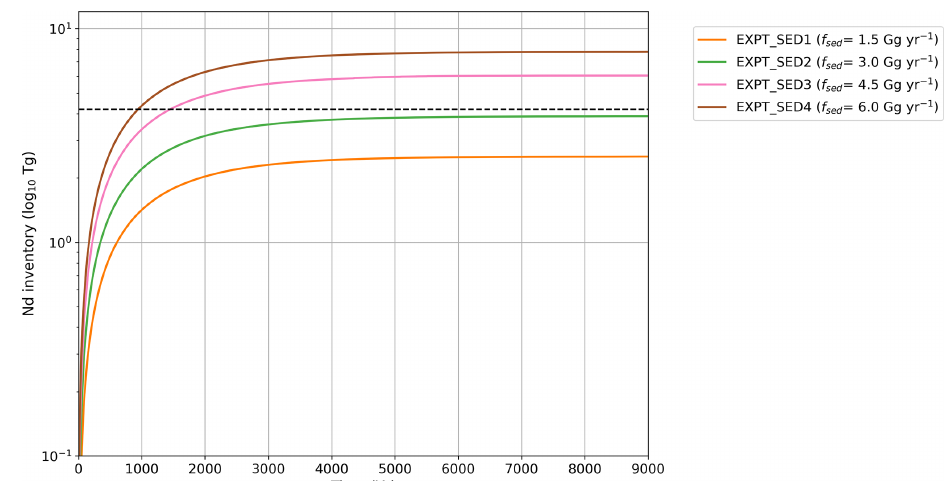
Figure 13. Global Nd inventory (Tg) simulated with different values for the total sediment flux tuning parameter ( f sed ) as indicated. The dashed line represents the estimated global marine Nd inventory of 4.2Tg from Tachikawa et al. (2003) used as an approximate target for the simulations. Note the logarithmic scale on the y